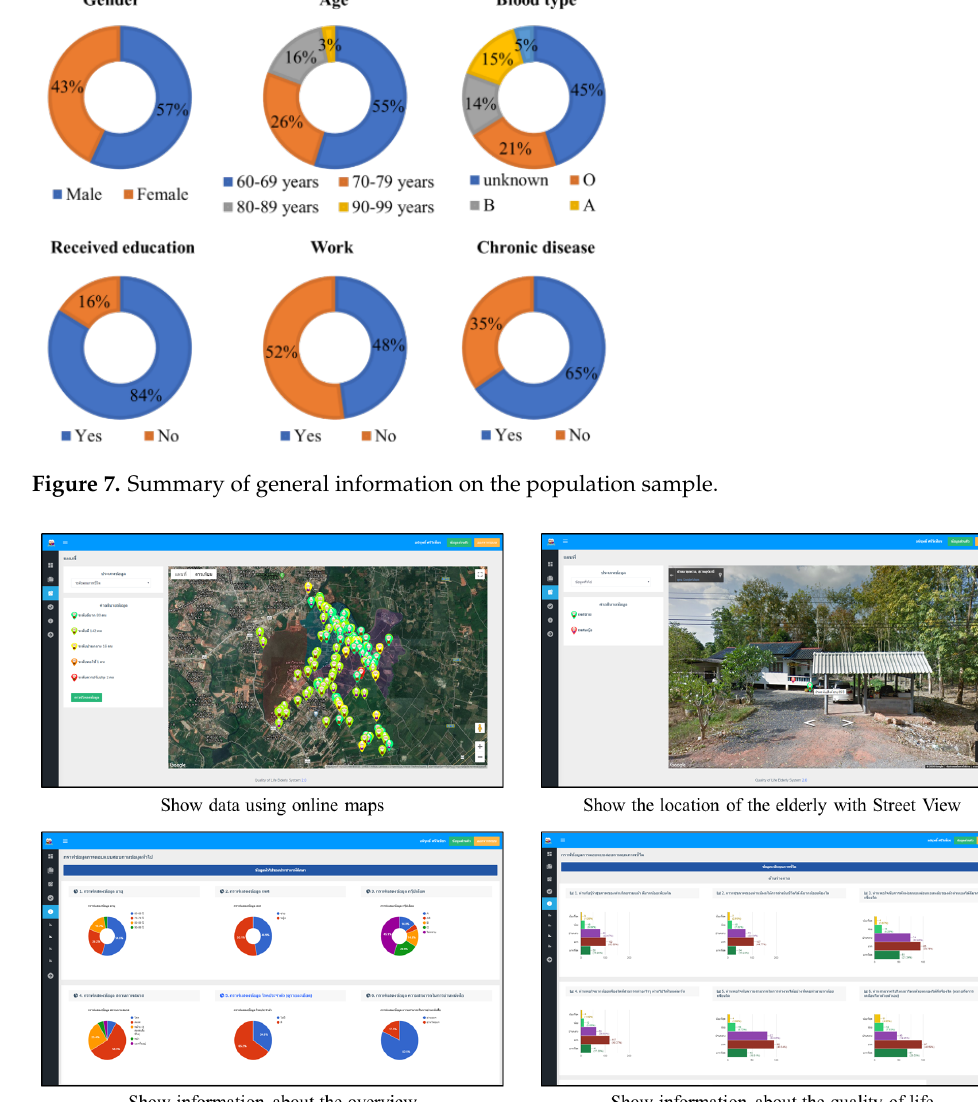
Figure 8. Example screen data